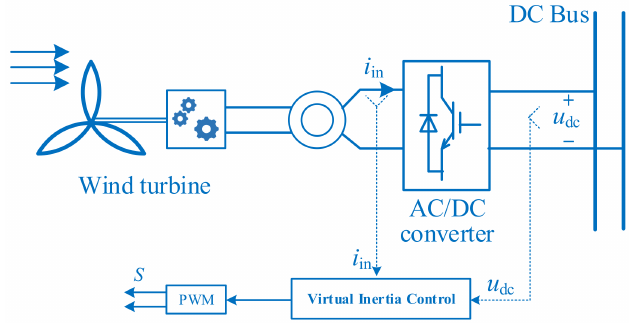
Figure 5. Schematic diagram of PMSG-based wind-generation system in dc